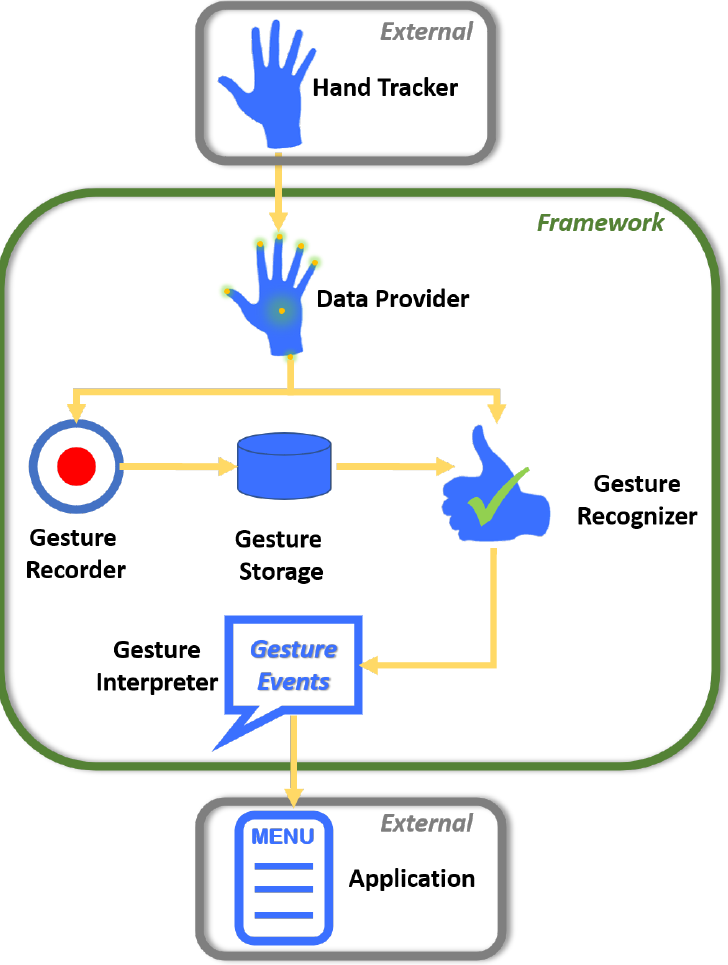
Figure 1. Overview of the proposed